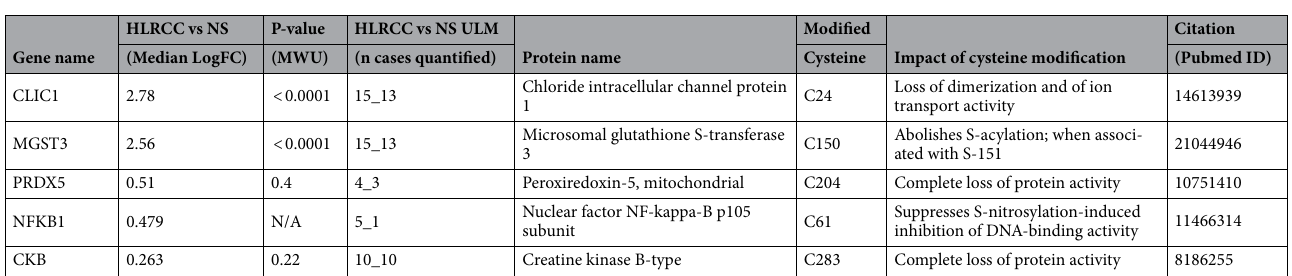
Table 4. Peptides quantified in HLRCC versus NS ULMs encoding functionally characterized 2-succinyl modified cysteine residues. 2SC modified PSMs elevated in HLRCC versus NS ULMs, denotes total number of ULMs candidates PSMs were quantified in, n# cases quantified, as well as specific residue, impact on protein function and supporting citations (Pubmed